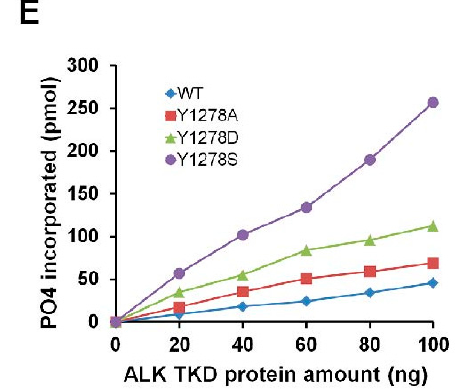
Figure 3. Importance of the Y1278-C1097 hydrogen bond for ALK kinase domain regulation. ( A , left